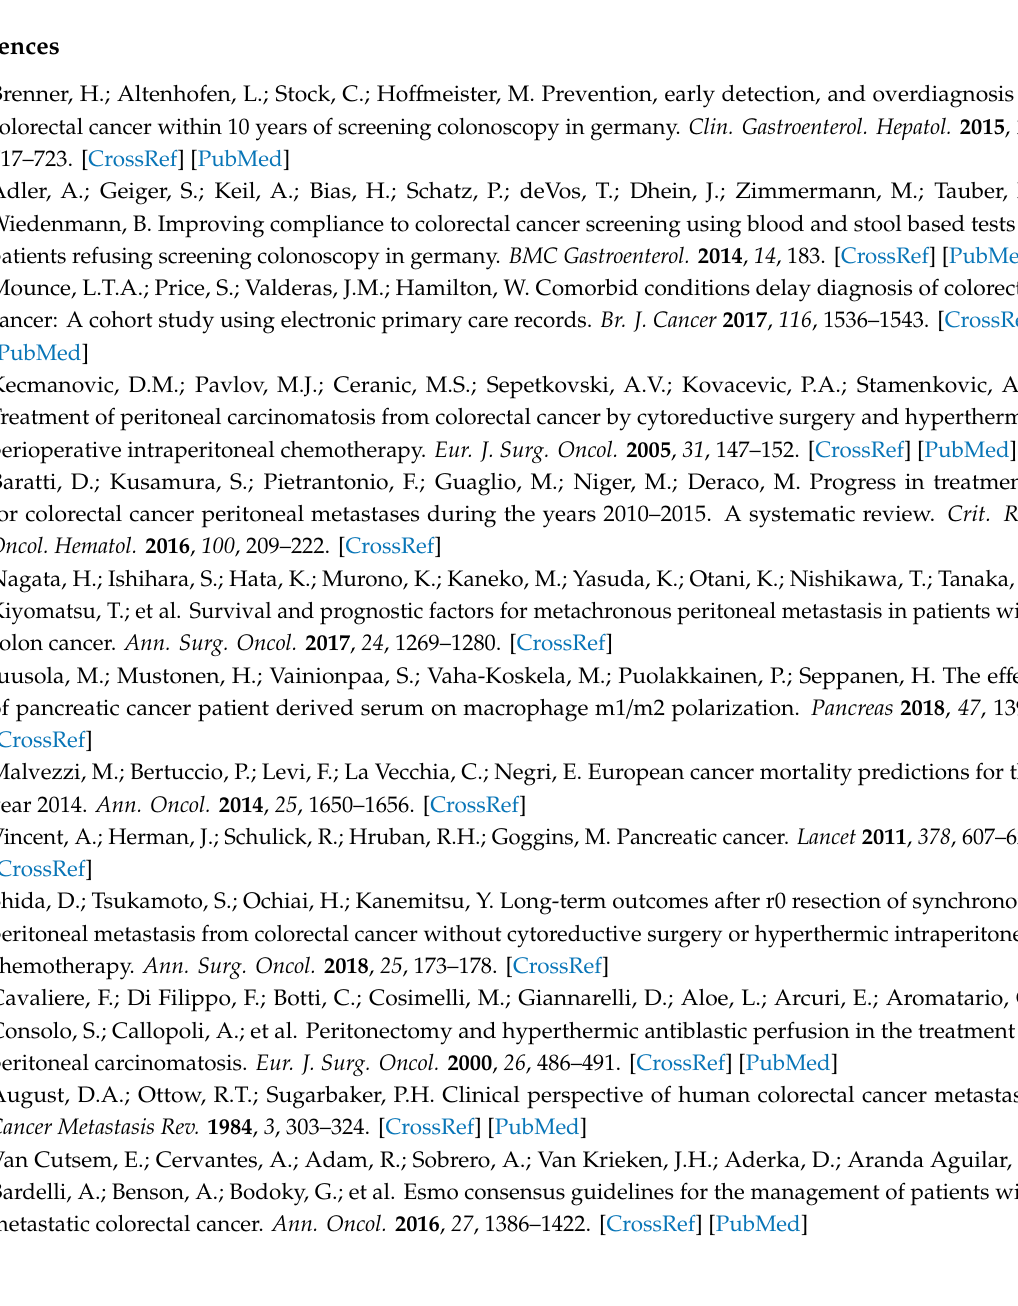
Figure S1: The sequence of combination treatment was not significant.; Figure S2: Generation of hydrogen peroxide through cold-physical plasma jets introduces metabolic and morphological rearrangements; Figure S3: Validation of the toxicity of selected kinase inhibitors with H 2 O 2 in 3D tumor cell spheroids of MiaPaca and Panc01 pancreatic cancer cells; Table S1: Concentrations of kinase inhibitors utilized in this